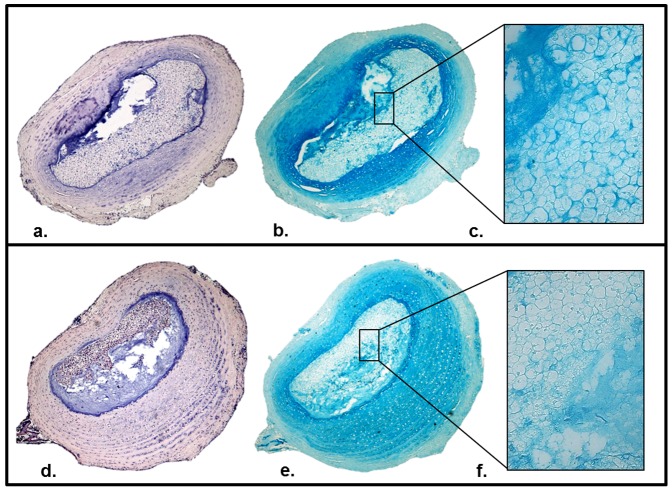
Histological analysis of explant micro-anatomic features.IVDs are shown in axial slices. (top pane) Freshly harvested murine IVDs. (bottom pane) Murine IVDs after 14 days of ex vivo culture. (a,d) Hematoxylin and eosin (b,e) Alcian blue. (c,f) 40× magnification of alcian blue stained NP.